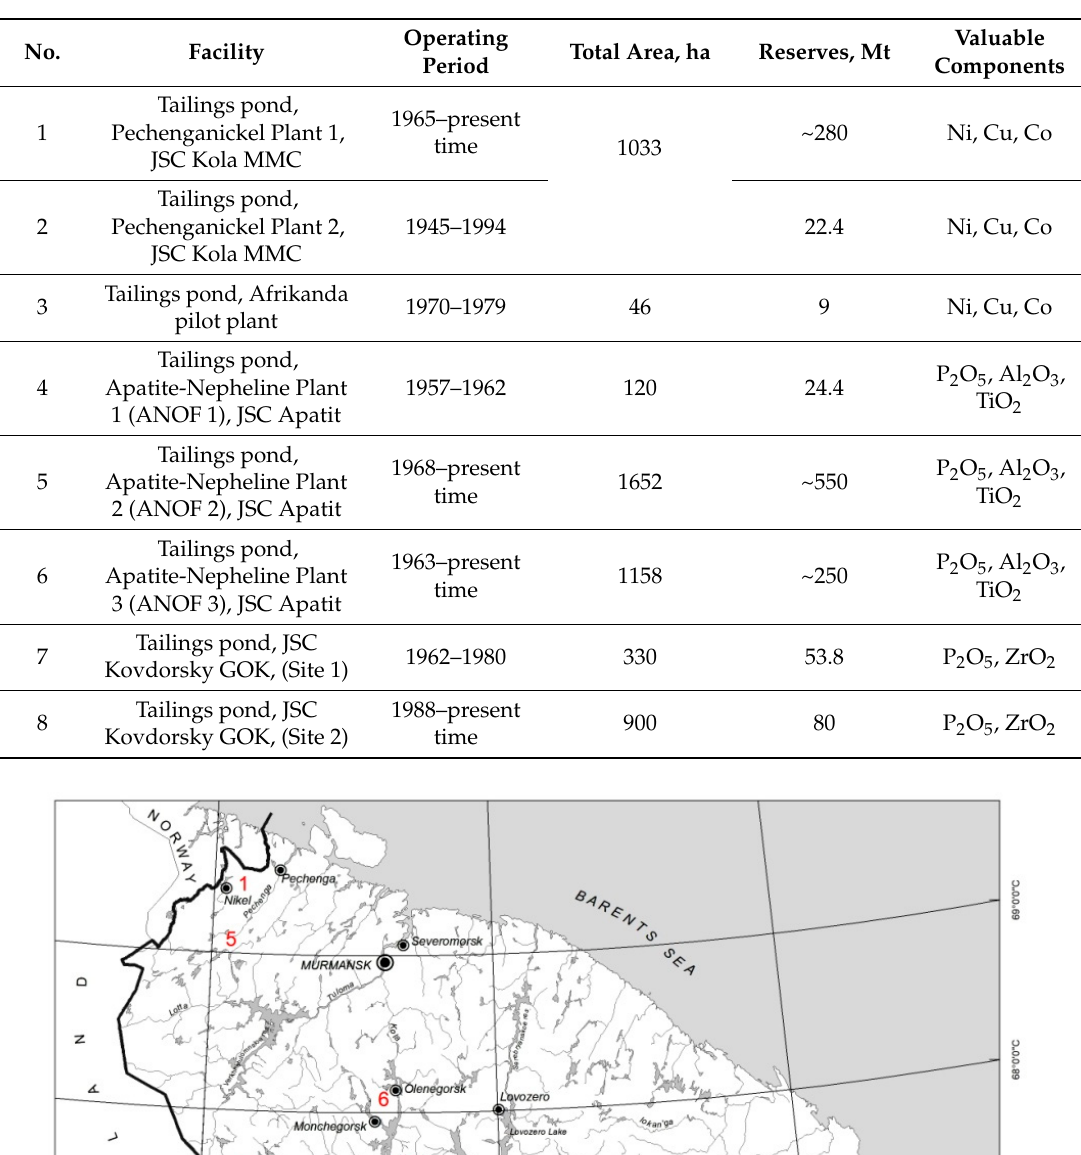
Table 1. Selected tailings ponds in Murmansk Region.